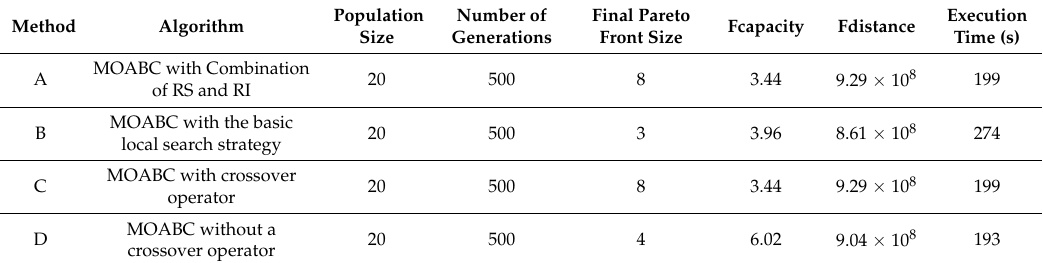
Table 2. Comparison of results obtained using different methods. RS—random swap; RI—random insertion.